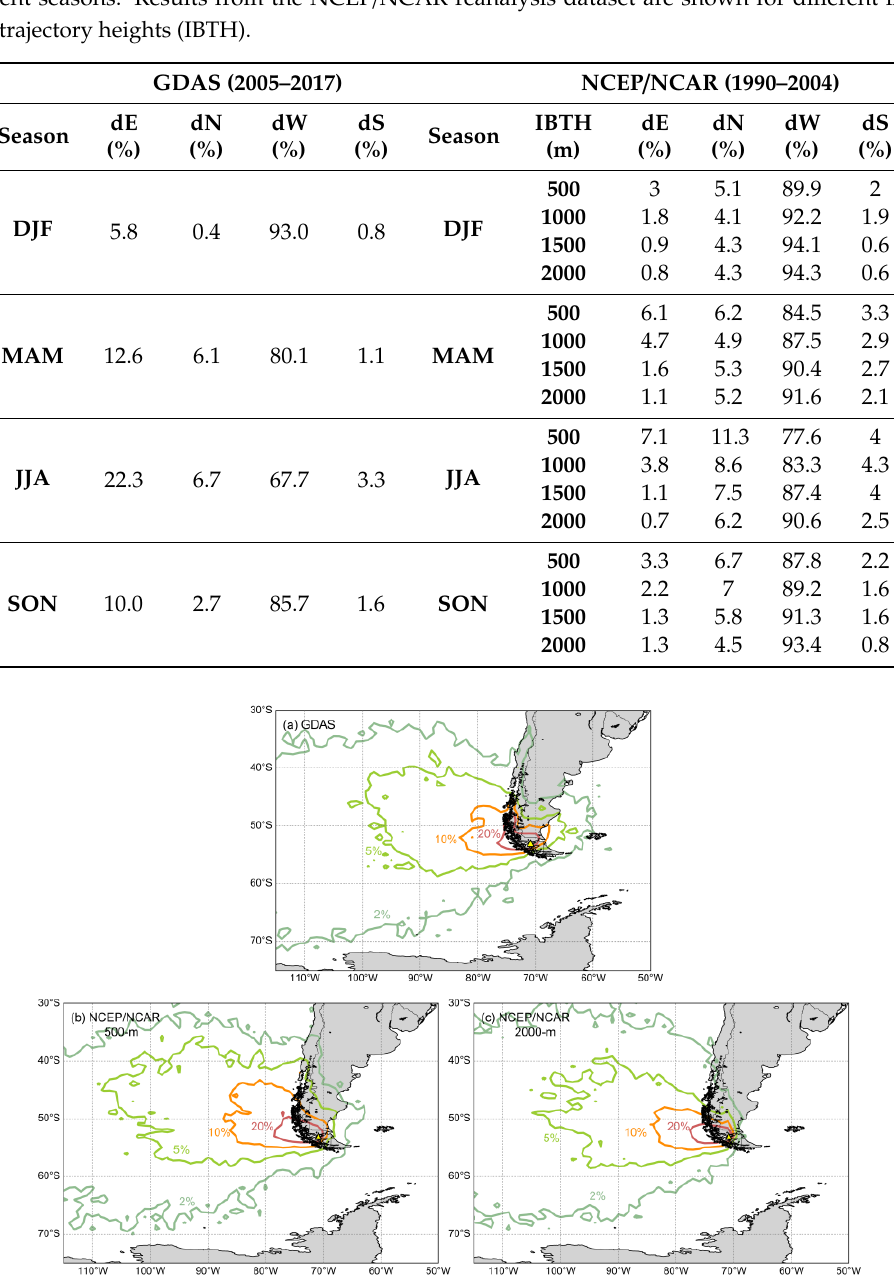
Figure 4. Trajectory frequency contours for precipitation-producing back-trajectories generated from ( a ) the GDAS reanalysis dataset (2005–2017) and from ( b,c ) the NCEP/NCAR reanalysis dataset (1990–2004) with an initial back-trajectory height of 500 m (b) and 2000 m (c), respectively.